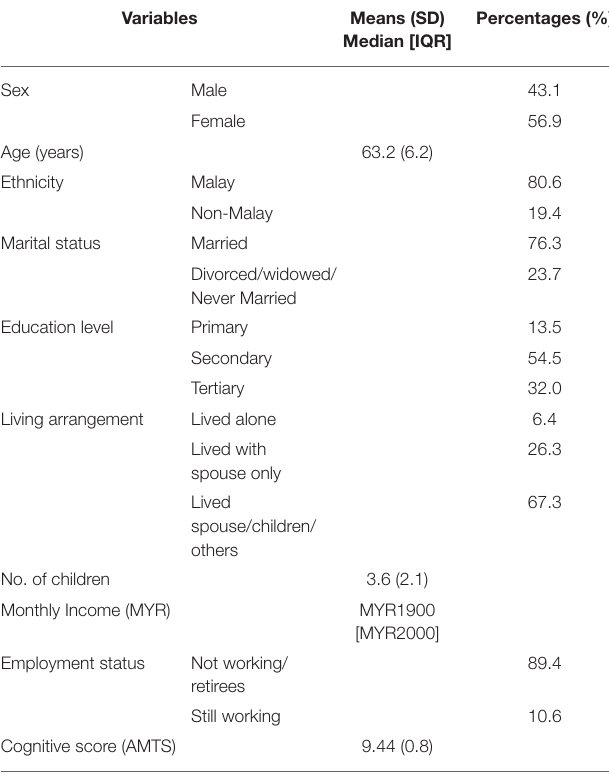
TABLE 1 | Socio demographic profile of respondents ( N =